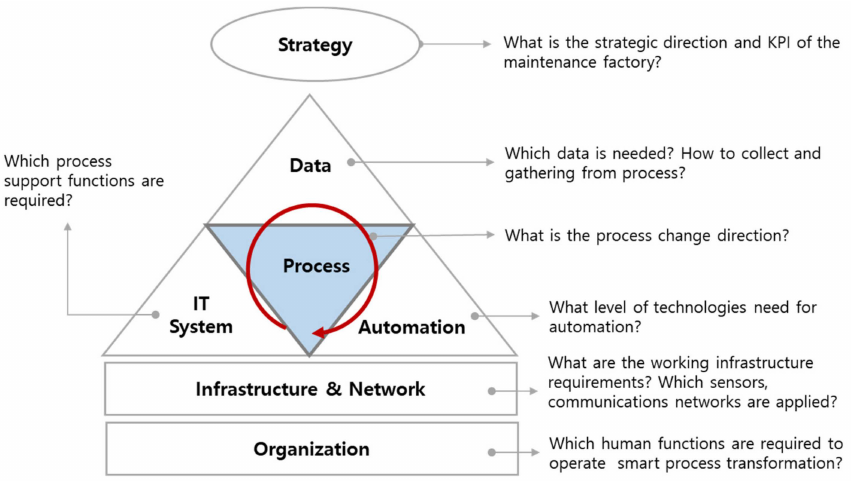
Figure 4. Smart process transformation framework.